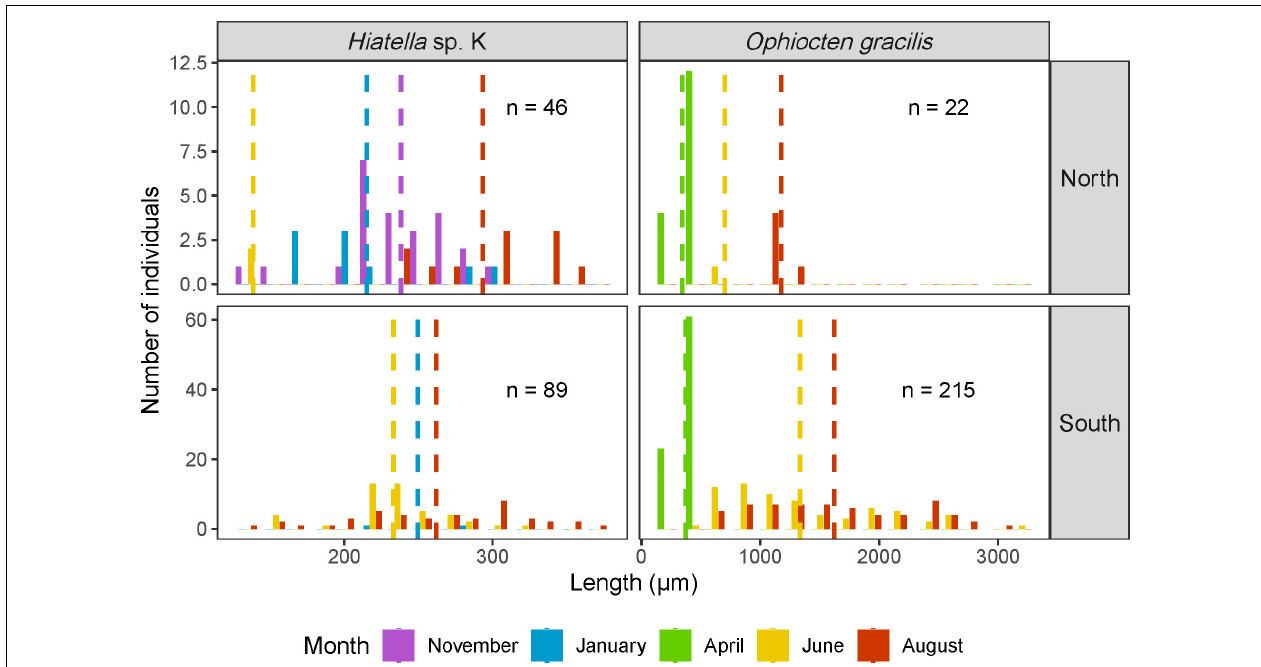
FIGURE 7 | Length-frequency distributions of larvae of Hiatella sp. K and Ophiocten gracilis , two meroplankton taxa with prolonged presence in the water column (at least three sampling events), north and south of the Polar Front. The colored dashed lines represent the mean length for each month and n represents the number of individuals contributing to each histogram.